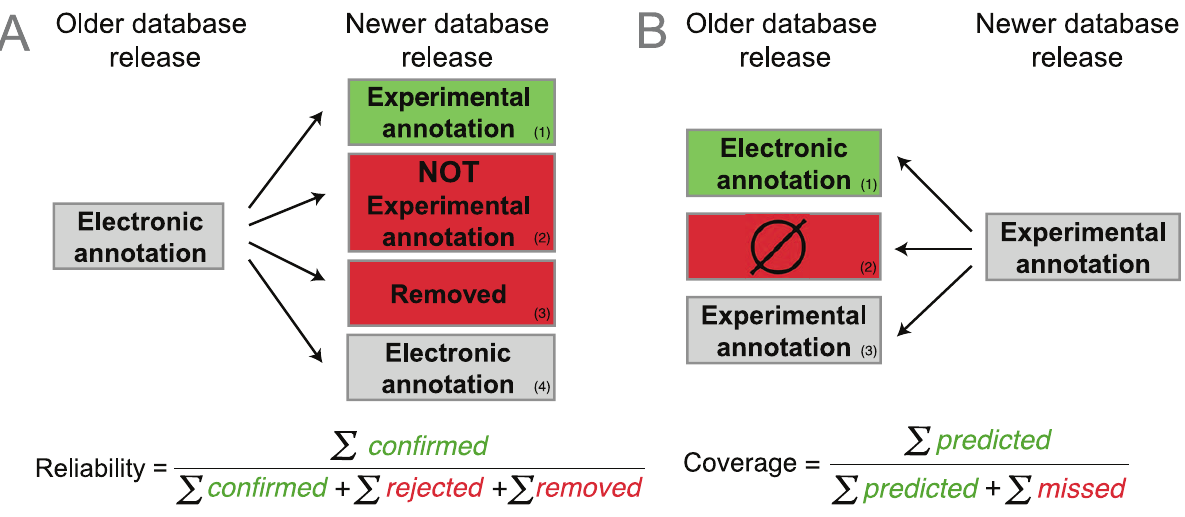
Figure 2. Outline of the strategy to evaluate electronic Gene Ontology annotations. ( A ) Reliability measures the proportion of electronic annotations confirmed by future experimental annotations: an electronic annotation in an older database release is either 1) confirmed by a new experimental annotation in the later release, 2) falsified by a new, contradictory experimental annotation (corresponding GO term, but with ‘NOT’ qualifier, which amounts to an explicit rejection), 3) removed from the new UniProt-GOA release (implicit rejection), or 4) unchanged, which is uninformative and does not affect the reliability measure. ( B ) Coverage measures the extent to which electronic annotations can predict future experimental annotations: an experimental annotation in the newer release is either 1) correctly predicted by an electronic annotation in the older release, or 2) not correctly predicted (‘‘missed’’). Note that the strategy is outlined for electronic annotations, but any subset of annotations can be analyzed this way, e.g. annotations assigned using a selection of evidence or reference codes.